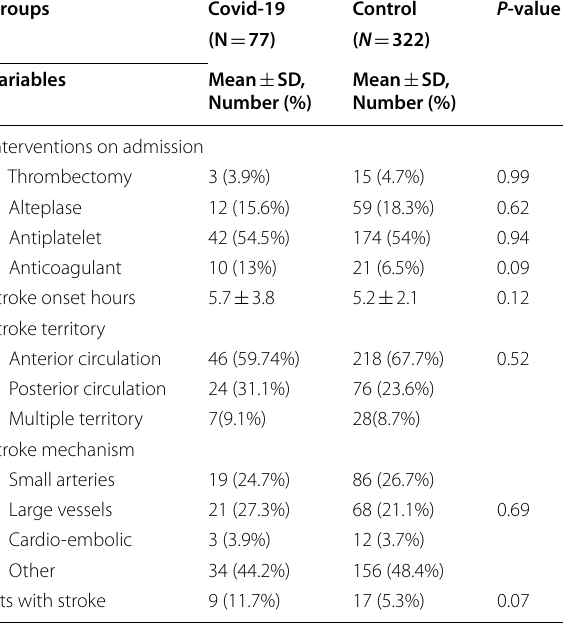
Table 2 Comparison between case and control